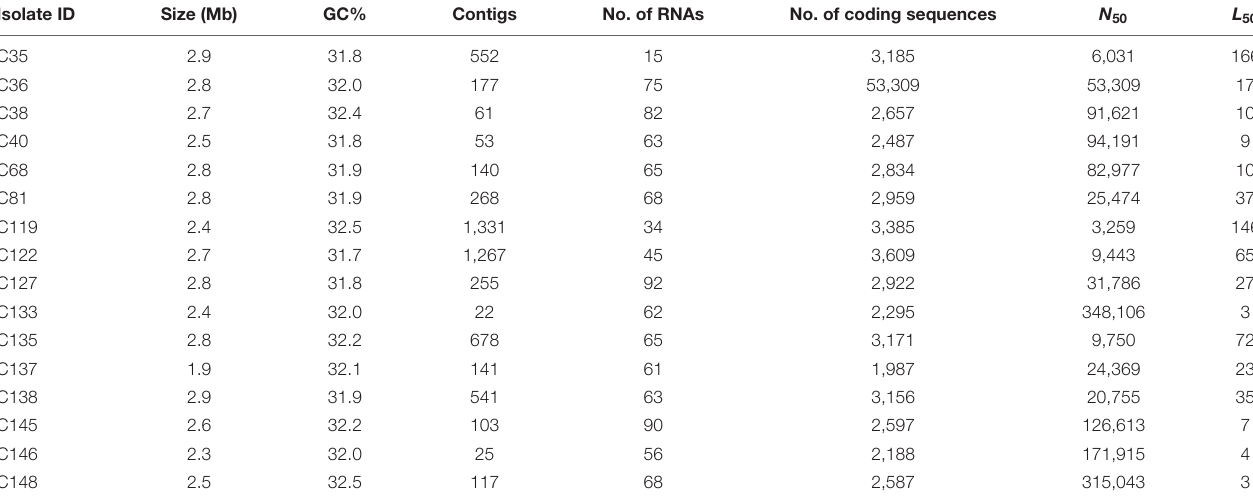
TABLE 2 | Genome and assembly characteristics of sequenced MRSE isolates from clinical sources. Isolate